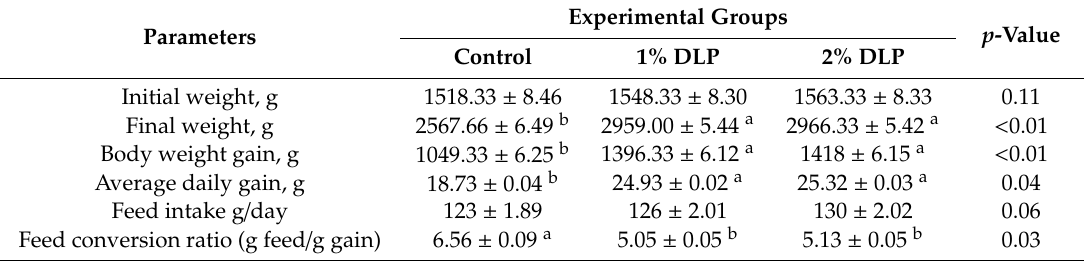
Table 3. The e ff ects of dried lemon supplementation on productive performance of growing